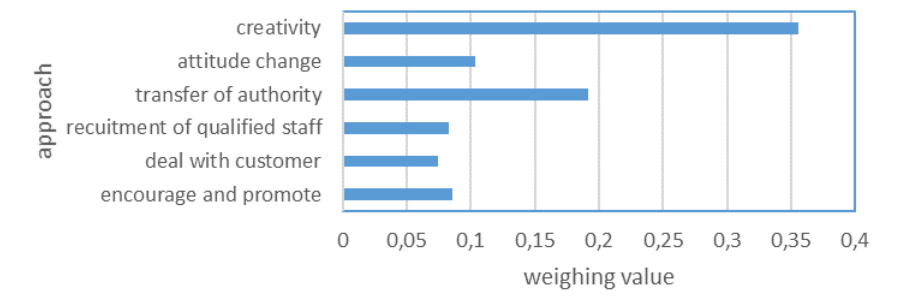
Figure 4: Result of personnel sub criteria weighing value (Inconsistency ratio=0.06)